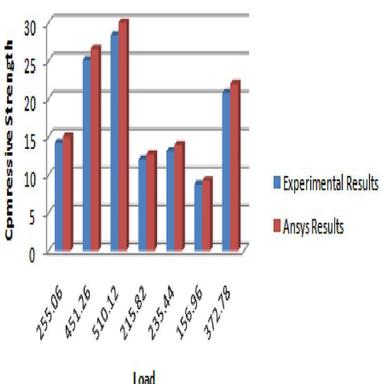
Comparison of Compressive Strength of C–C Laminate specimen using Experimentation and Ansys.